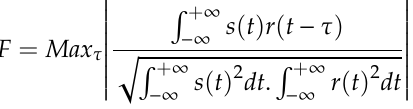
Figure 9. ( a ) Radiation/total efficiencies, maximum gain and ( b ) diversity results of the diversity antenna.